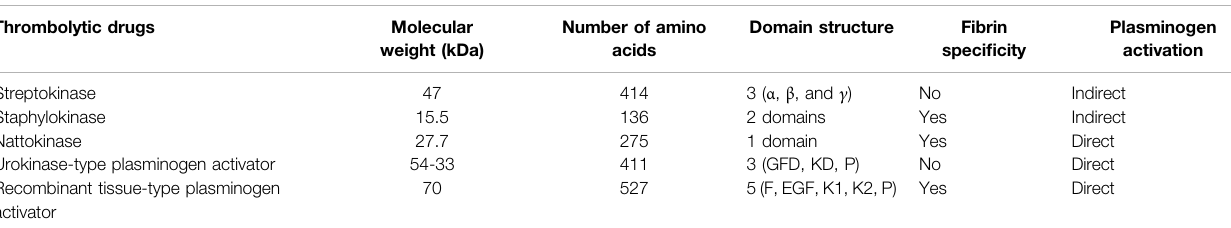
TABLE 7 | Comparison of different thrombolytic